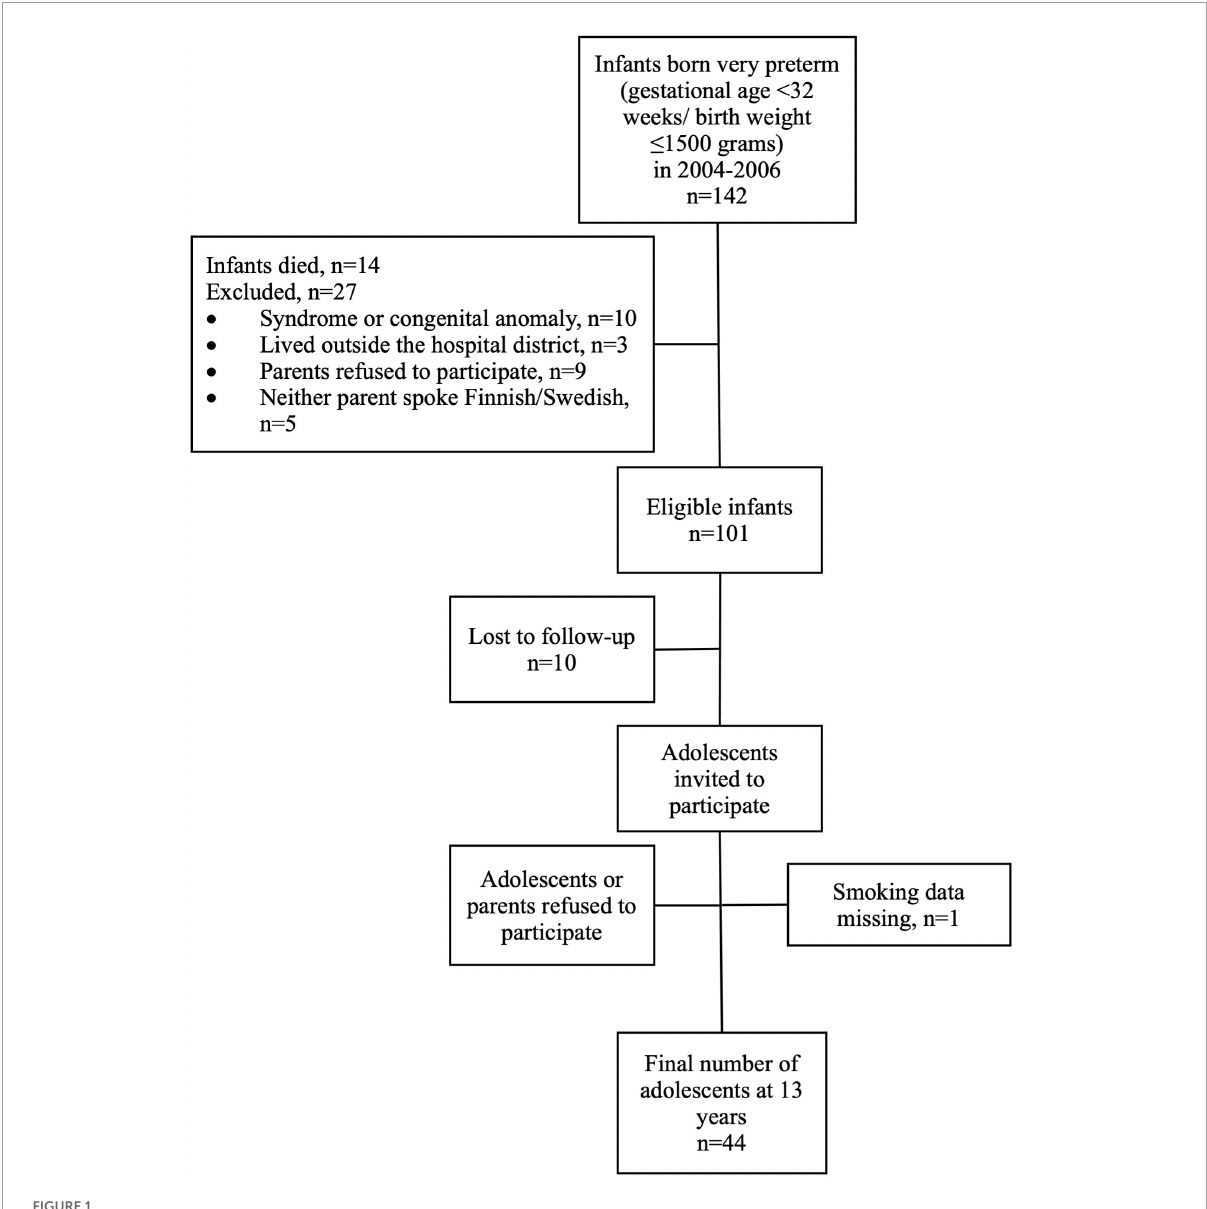
FIGURE1 Flow chart of the study